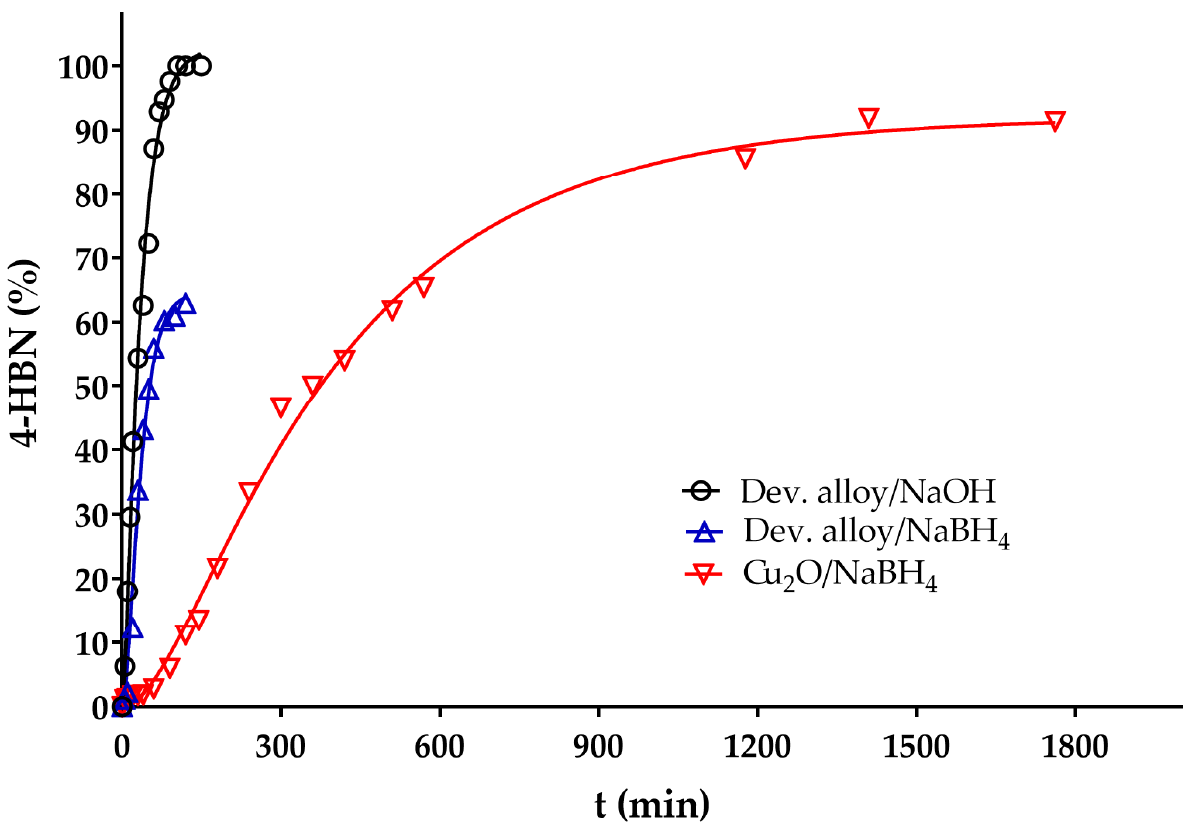
Figure 13. Time dependence of the 4-HBN formation by the HDB of BRX using different HDB systems.